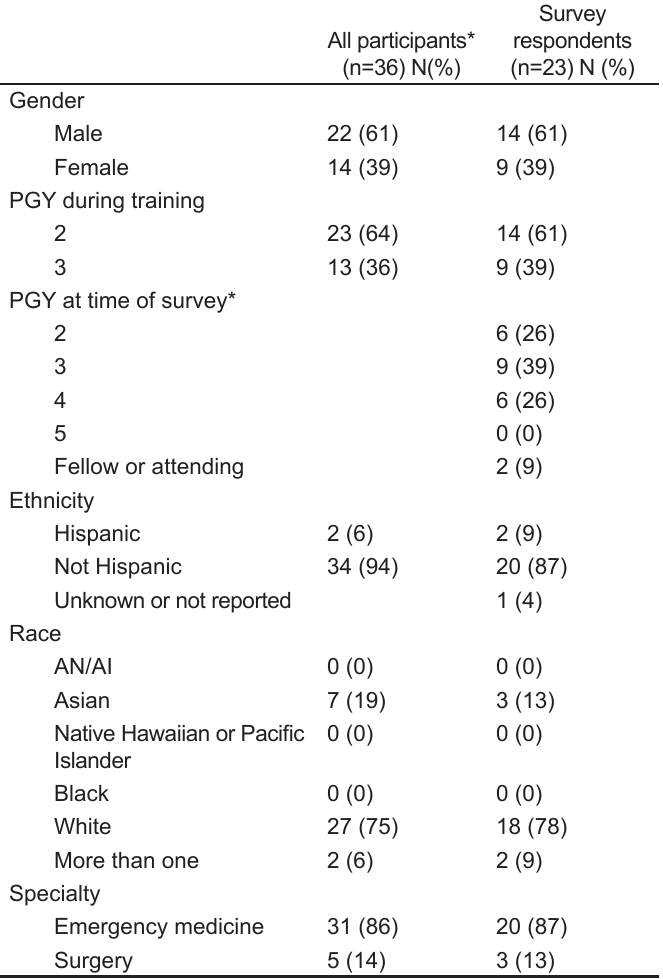
Table 2. Demographics of training participants and training evaluation survey